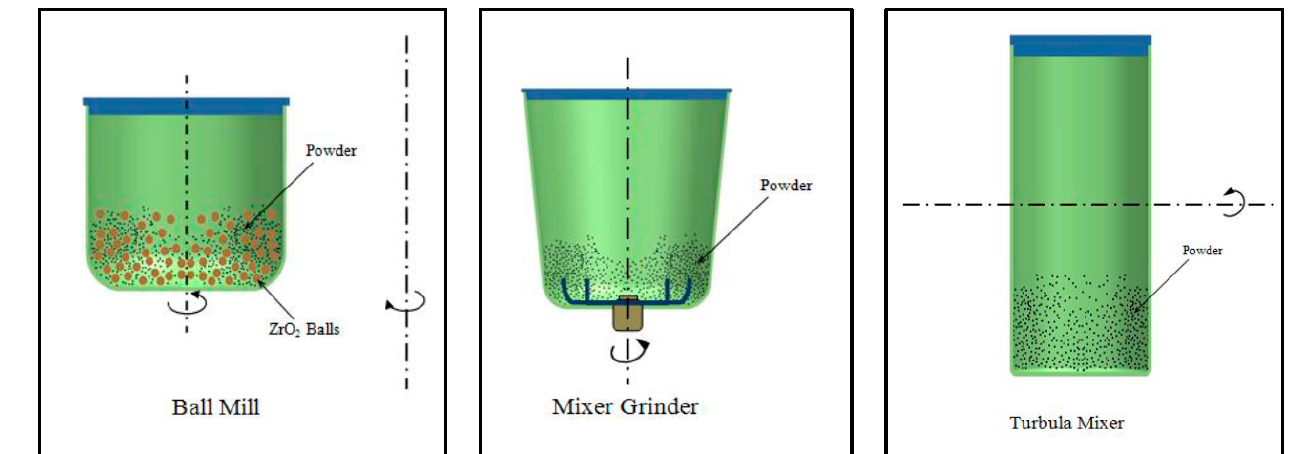
Figure 3. The mixing techniques followed for mixing powdered iron oxides with the reducing agents.